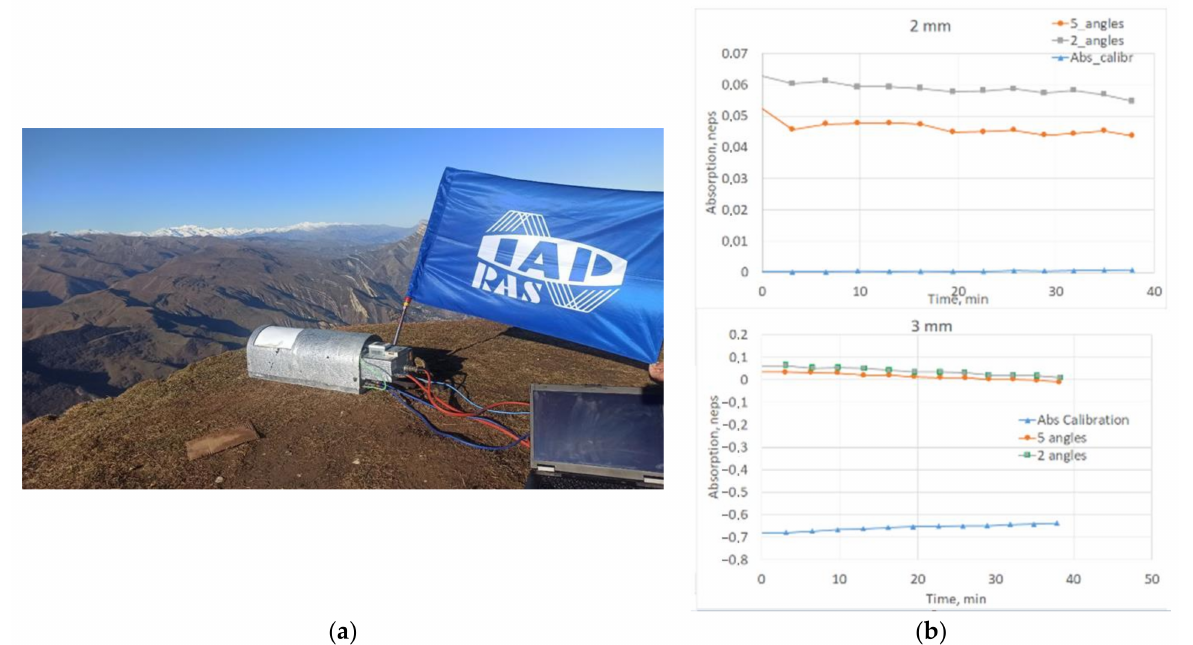
Figure 9. ( a ) Dagestan, Miskindja, Mount Shalbuzdag, 4142 m. ( b ) Measurements at λ 3 mm τ = 0.07–0.1 Np at 3600 m and at 2900, respectively, at λ 2 mm τ = 0.07–0.12 Np at 3600 m and at 2900, respectively, 7 November 2021. In terms of the water vapor level, it corresponds to a very impressive PWV 2–4